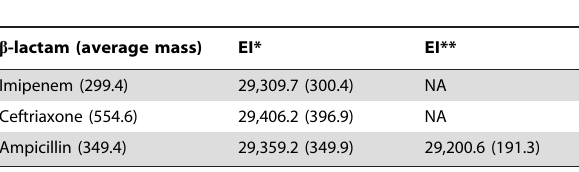
Table 1. Average mass of acylenzymes (mass increment) a